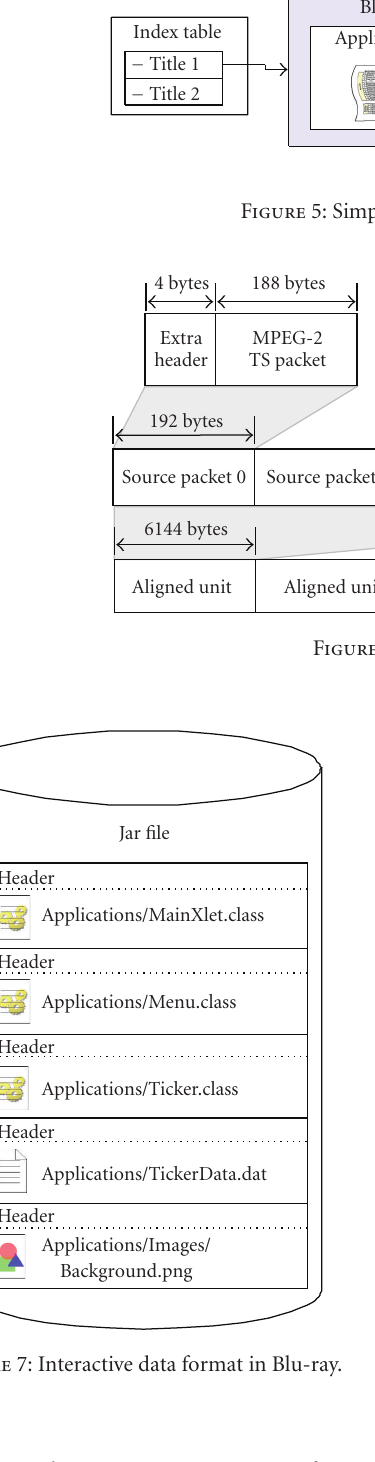
method to transcode DVB-MHP system information